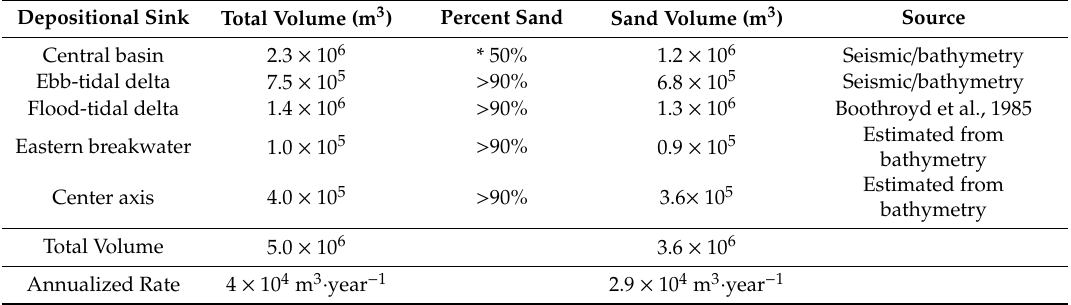
Table 3. Total volume, percentage sand, and estimated sand volume of the depositional sinks within the HoR (* grainsize ranges from 30% to > 80% sand; 50% likely represents a conservative estimate). Depositional